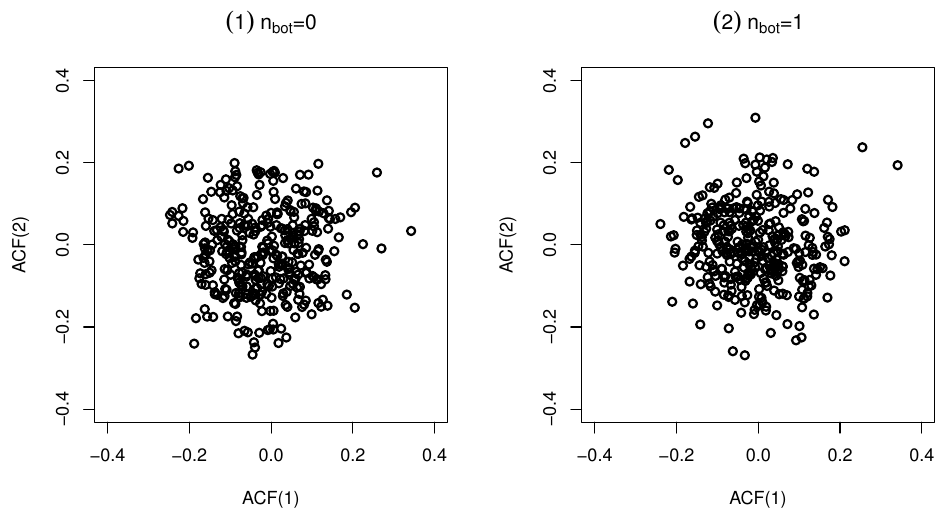
Figure 5. Plots of attainable pairs of ACF(2) against ACF(1) for n top = 10 with c =